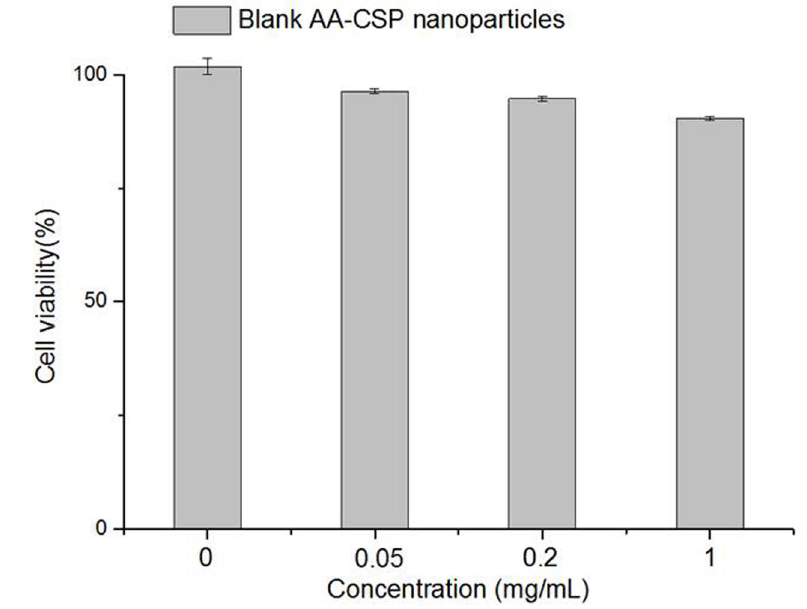
FIGURE 8 - Biocompatibility measurement of AA-CSP nanoparticles on HUVEC